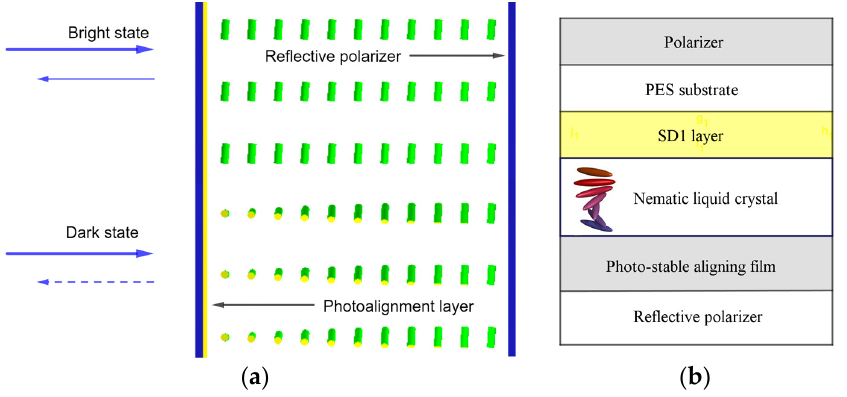
Figure 3. (Color online) ( a ) Schematic representation of twisted nematic liquid crystal cell. ( b ) Device structure of ORW e ‐ paper.